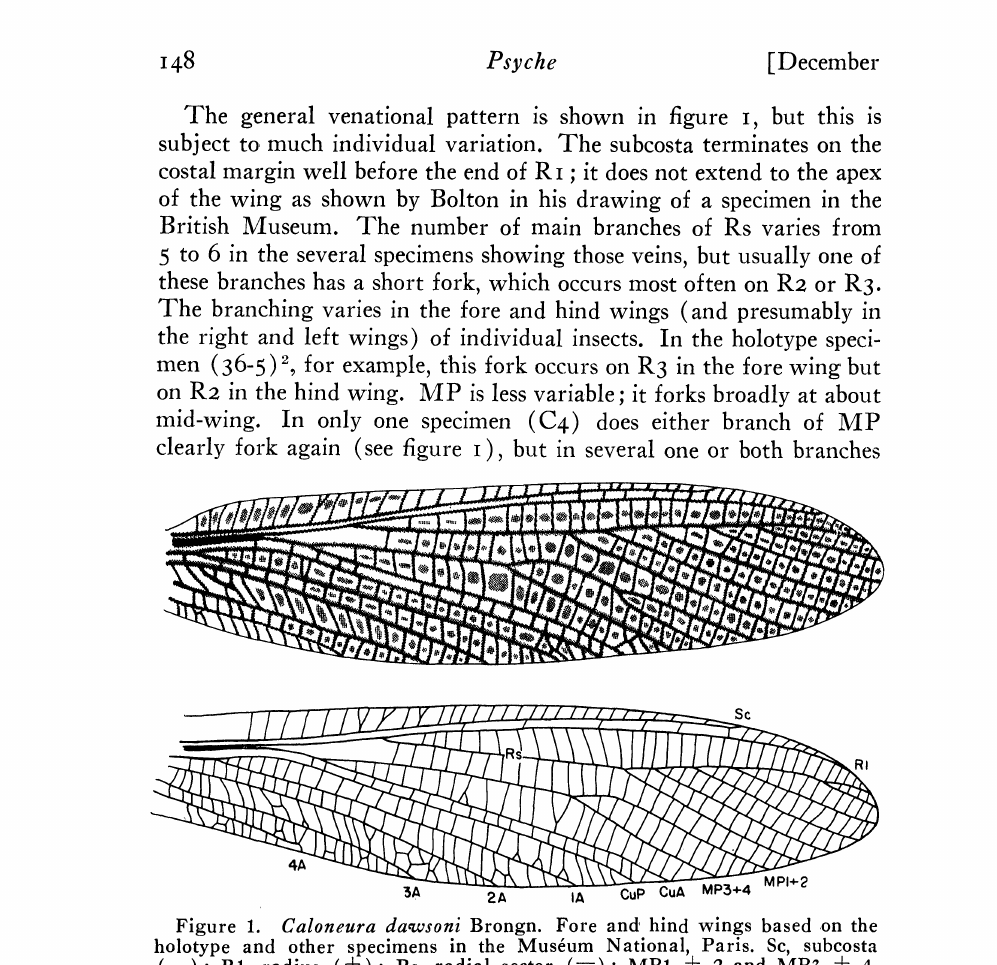
Figure 1. Caloneura daw’soni Brongn. Fore and’ hind wings based .on the holotype and other specimens in the Mus6um National, Paris. Se, subeosta (--); R1, radius (+); Rs, radial sector (--); MP1 + 2 and MP3 + 4, branches of posterior media (--) 1A, 2A, 3A, 4A, anal veins. appear to. have a small, terminal fork. CuA_ and CuP are consistently unbranched; the divergence of CuP and I.A, near the base of the wing, is either shallow or somewhat broader. The four anal veins are con- sistently